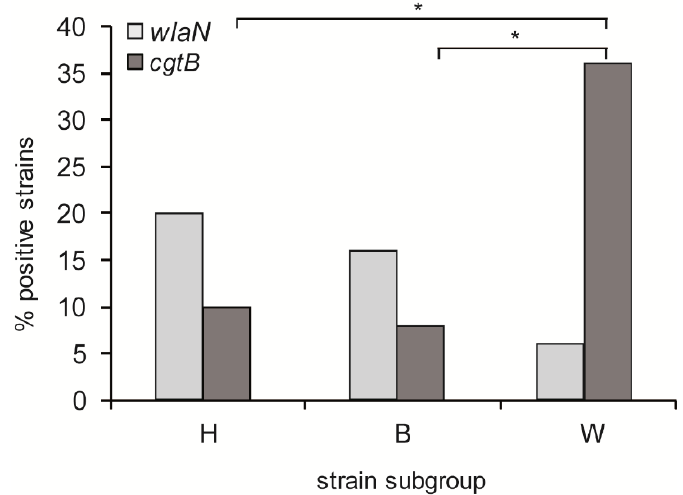
Figure 1. Prevalence of wlaN and cgtB genes in C. jejuni strains from different origins. H, human patients; B, broiler chickens; W, wild birds. Statistical analyses were performed using Pearson’s chi-squared test (R Studio software). p < 0.005 was considered statistically significant (indicated by an asterisk).